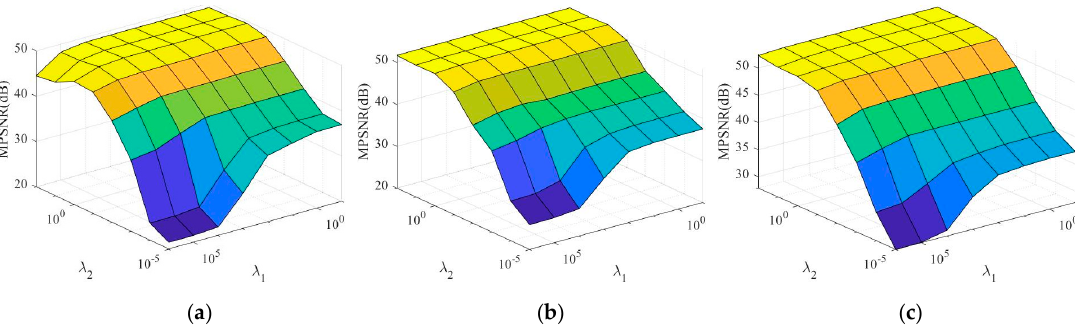
λ λ and of the proposed DCHS 1 2 ff erent sampling rates SR . ( a ) L g or di g = 20, L or different sampling rates SR . algorithm with di g